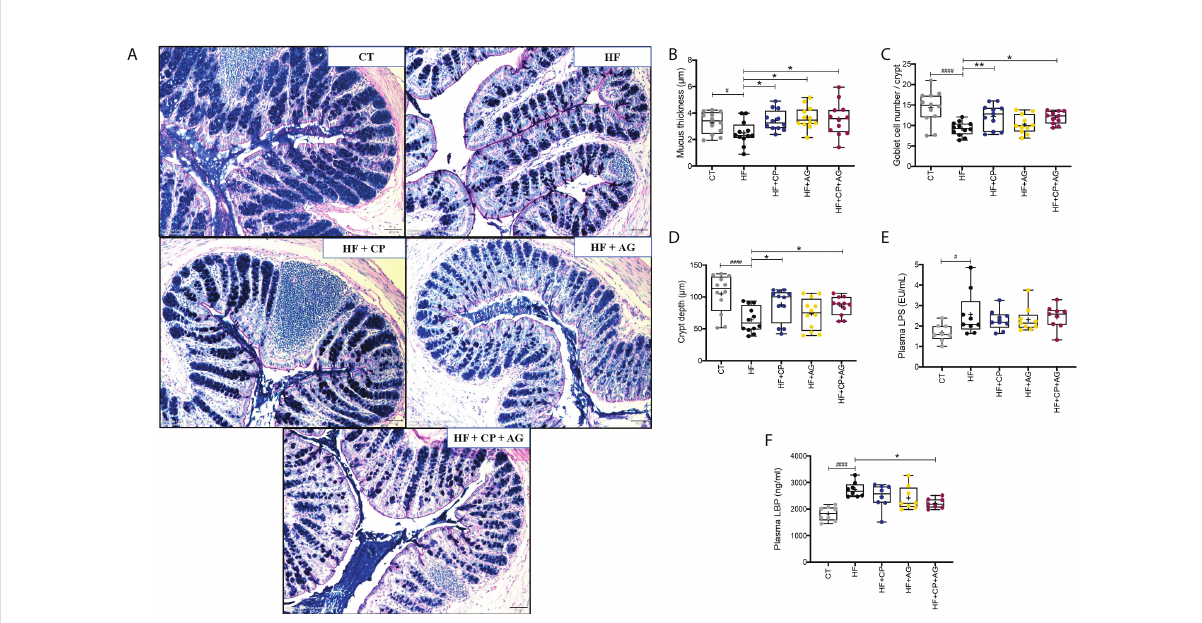
FIGURE 5 Cranberry polyphenols and agavins improved colonic mucus thickness and mucin-secreting goblet cell number, and also reduced circulating levels of lipopolysaccharide-binding protein in HFHS-diet induced obese mice. (A) The effect of HFHS-diet (HF) and the supplementation with cranberry polyphenols (CP), agavins (AG), and CP+AG were studied in representative histological images of the colon tissues of mice. A combination of Alcian Blue and periodic acid – Schiff staining (AB/PAS) was used to distinguish acidic (dark blue) and neutral (red) mucins. A purple color indicates the presence of both acidic and neutral mucins. Images shown are representatives of examined mice (n = 12) in each group. Images were taken using objective lens UPLSAPO 20×/0.75, magni fi cation 12.6×, scale 50 m m. Histological parameters were evaluated in cross sections of colon tissues stained with AB/PAS staining: (B) mucus thickness ( m m); (C) total goblet cell (GC) number per m m of crypt; (D) crypt depth ( m m). (E) Plasma LPS (EU/mL); (F) plasma LBP (ng/ml). Ordinary one-way ANOVA with a Dunnett ’ s multiple-comparison test ( post- hoc test) was employed to calculate the signi fi cance of the differences between groups. Boxplots represent the distribution of data with the mean represented by the mark “ + ” within the boxes, the median represented by the dark horizontal line and interquartile range by the box, * p < 0.05, ** p < 0.01, as compared to HFHS-control group. # p < 0.05 and #### p < 0.0001 chow-control group versus HFHS-control